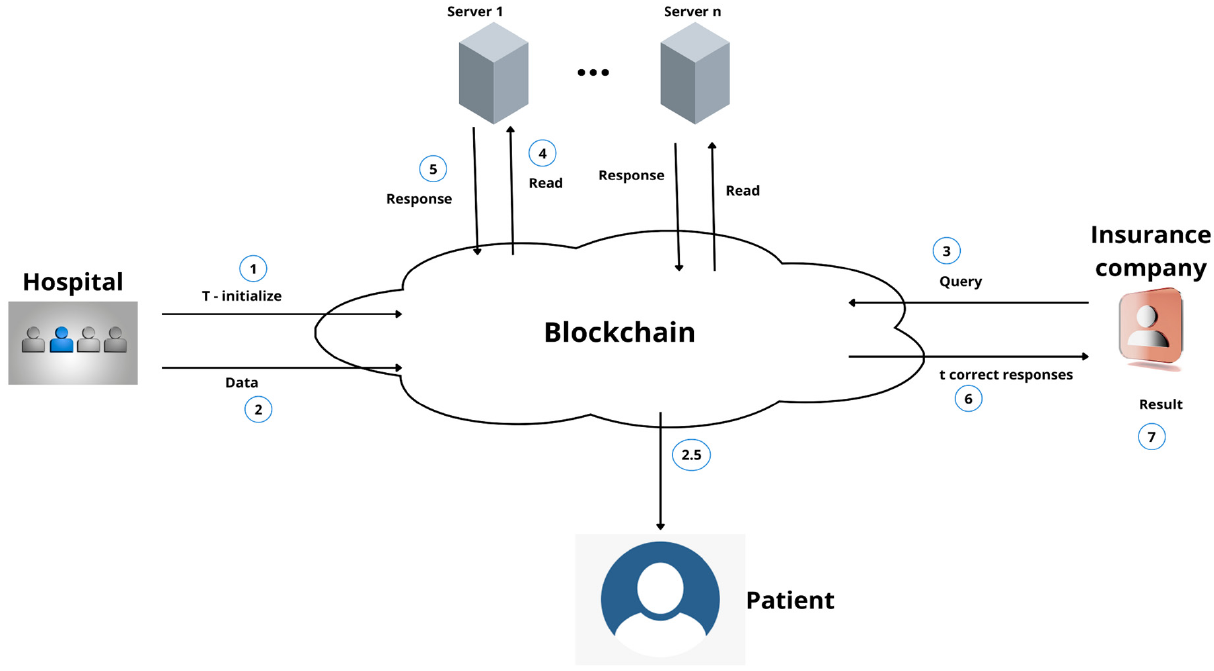
Figure 16 . The basic structure of MIStore. Arrows represent the flow of data while the numbers represent the sequence of the processes.